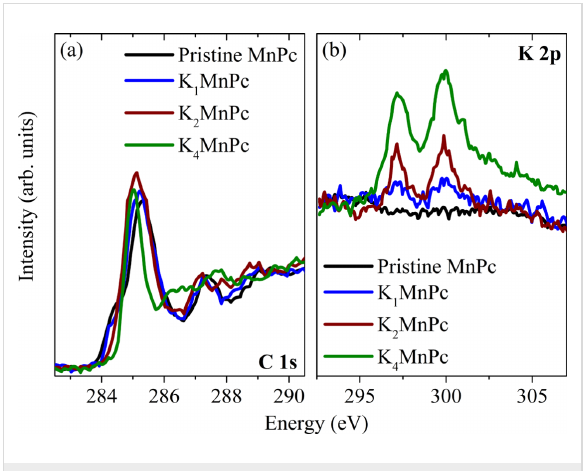
Figure 3: C 1s (panel (a)) and K 2p (panel (b)) excitation edges of MnPc and the three potassium-doped phases (adapted from [56]). The relative intensities of these two edges were used to analyze the com- position of the doped